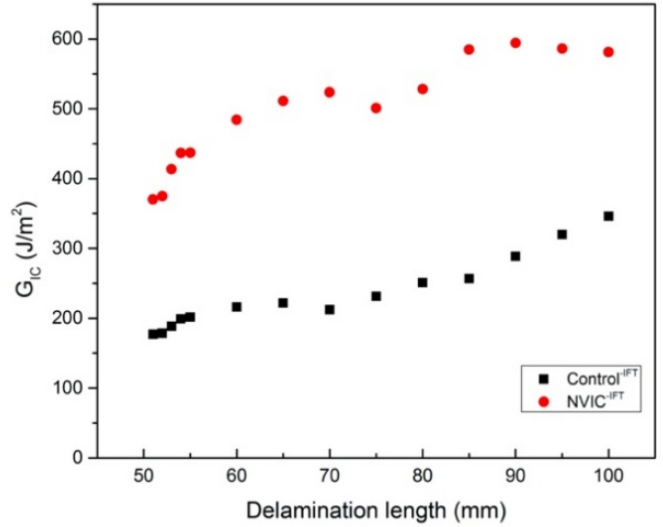
Figure 8. Typical R-curve for Mode I toughness test.